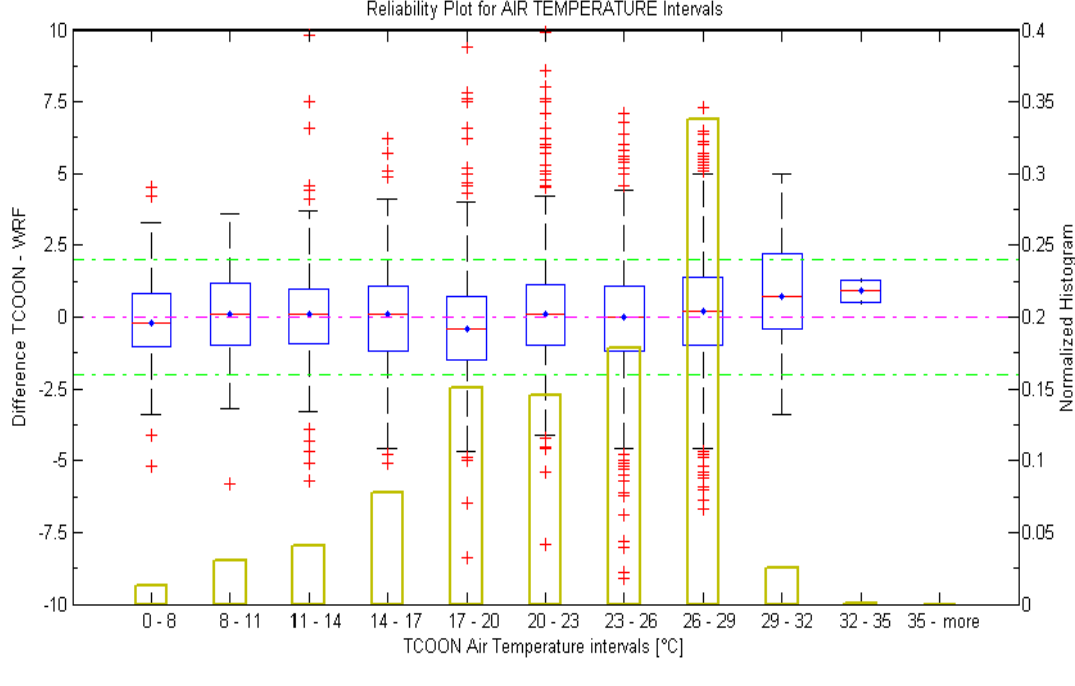
Figure 26. Boxplot showing the differences between measured and predicted temperature values for the TCOON site “Bob Hall Pier” for different air temperature bin intervals. The measured (TCOON) temperature histogram is shown for